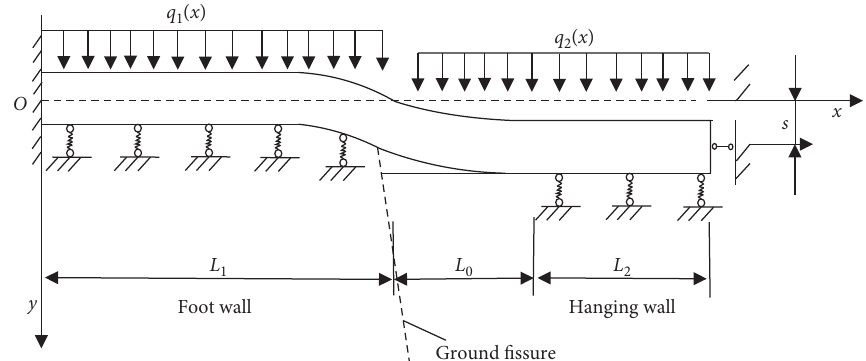
Figure 7: Load pattern of the utility tunnel crossing ground fissure section.